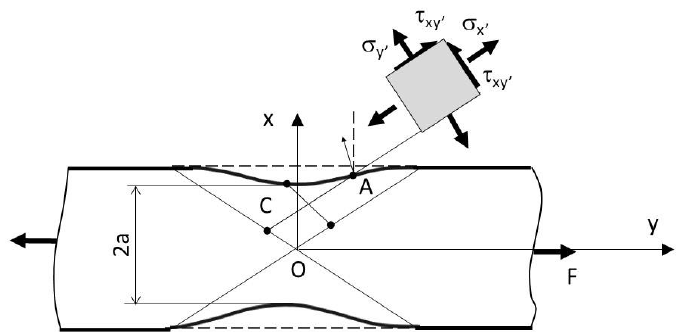
Figure 4. Geometric interpretation of the strain identification, following [29].